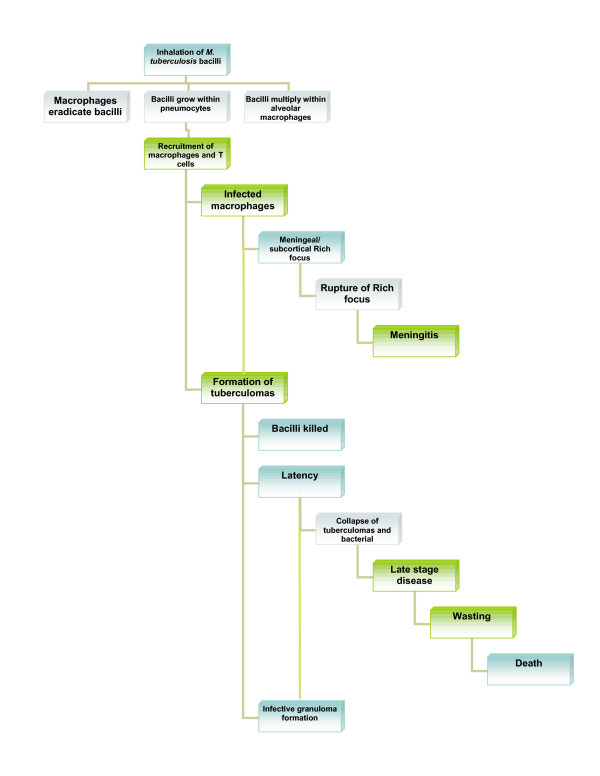
Pathogenesis of TB.